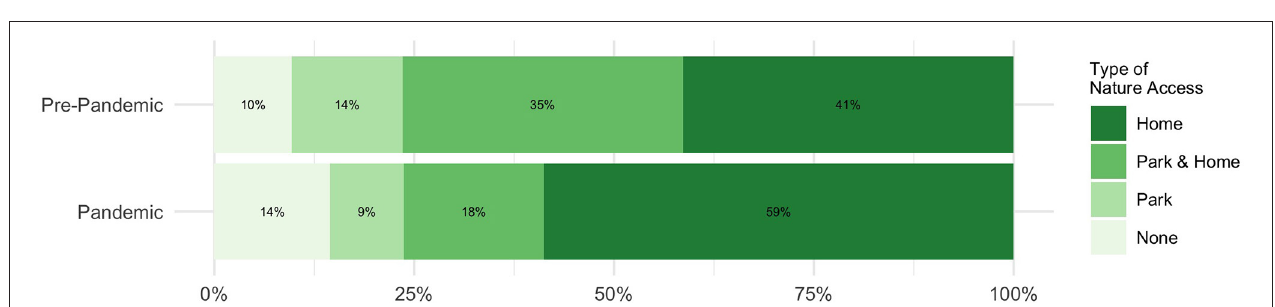
FIGURE 3 | Type of nature access for the full sample before (pre-) and during (mid-) the pandemic. None indicates not spending time in nature; Park indicates just time in public parks or natural areas; Park and Home indicates time in both public and private natural areas; and Home indicates just time in a private yard or garden.